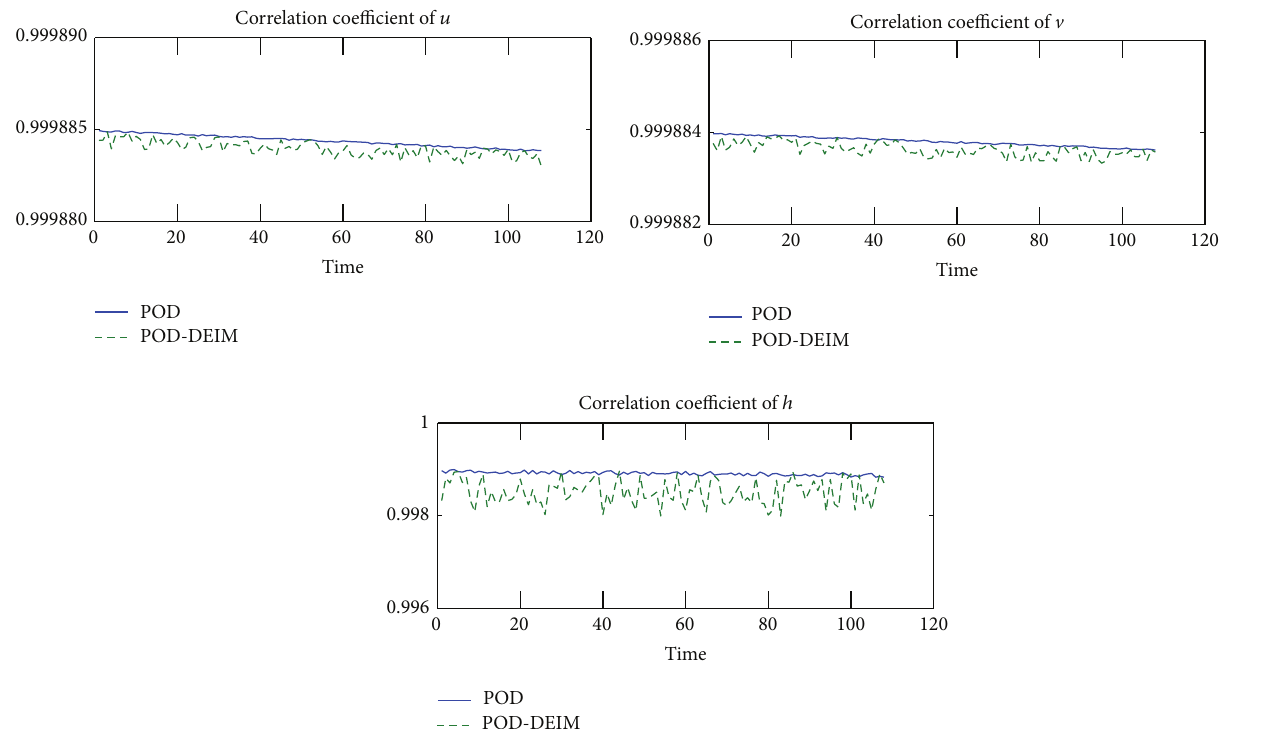
Figure 6: Comparison of the correlation coefficients with POD and POD-DEIM for 𝑢 , V , and geopotential. The number of DEIM points was taken 60.